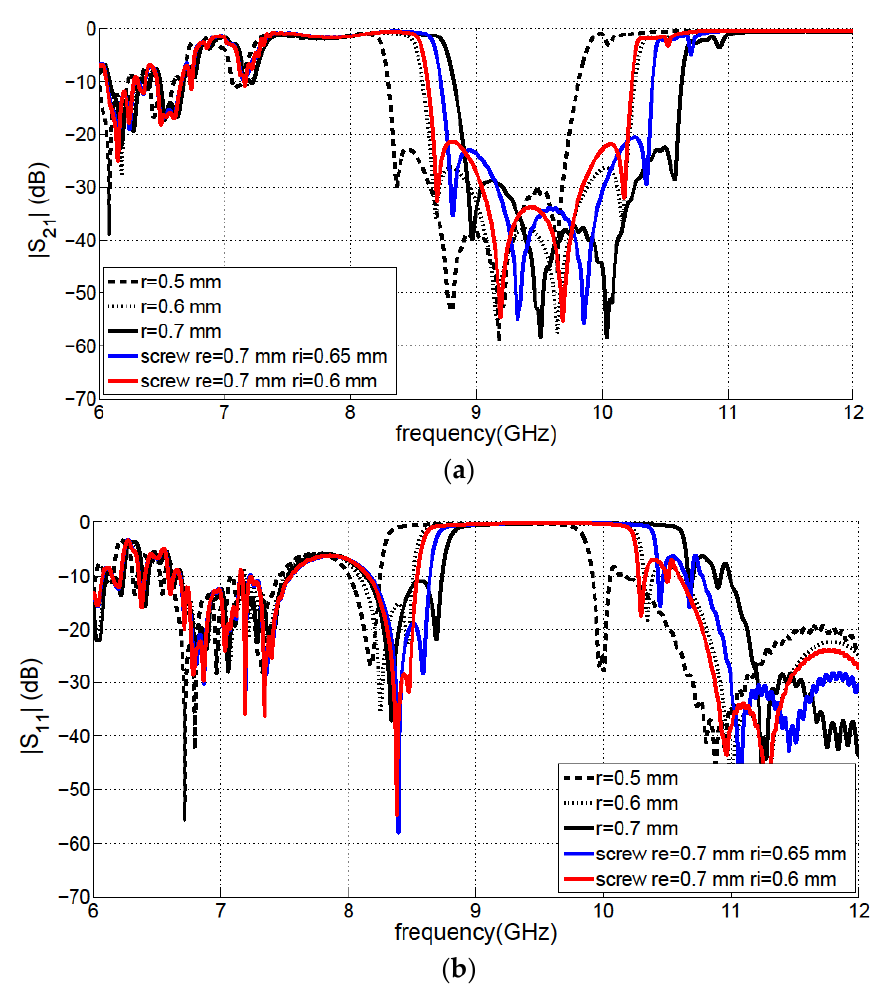
Figure 14. Simulated S-parameters for the proposed 5-cell EBG-filter for different short-circuit